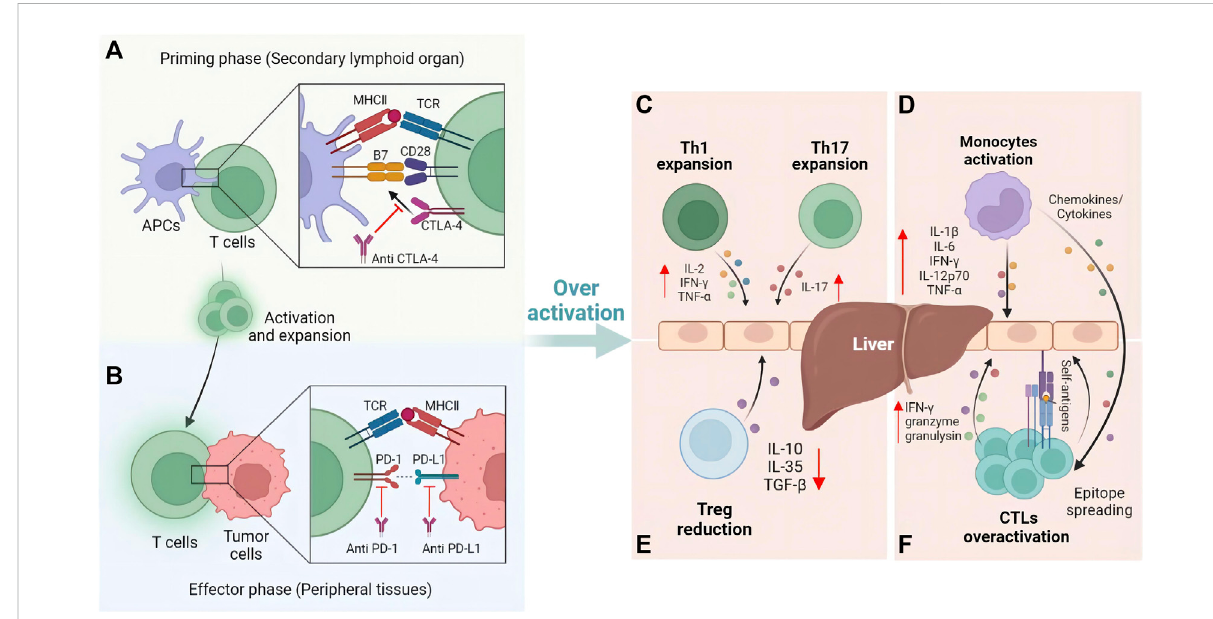
FIGURE 1 Mechanisms ofT cells activation and immune-mediated hepatitis caused by ICIs. (A) Blockade of CTLA-4 activates T cells at thepriming phase. (B) Further anti-tumor effect induced by the blockade of PD-1 and PD-L1 occurs in the effector phase. Once liver self-tolerance impairs, immune cells such as (C) Th cells, (D) Monocytes, (E) Treg cells, and (F) cytotoxic T cells will be involved in the pathophysiological process of immune- mediated